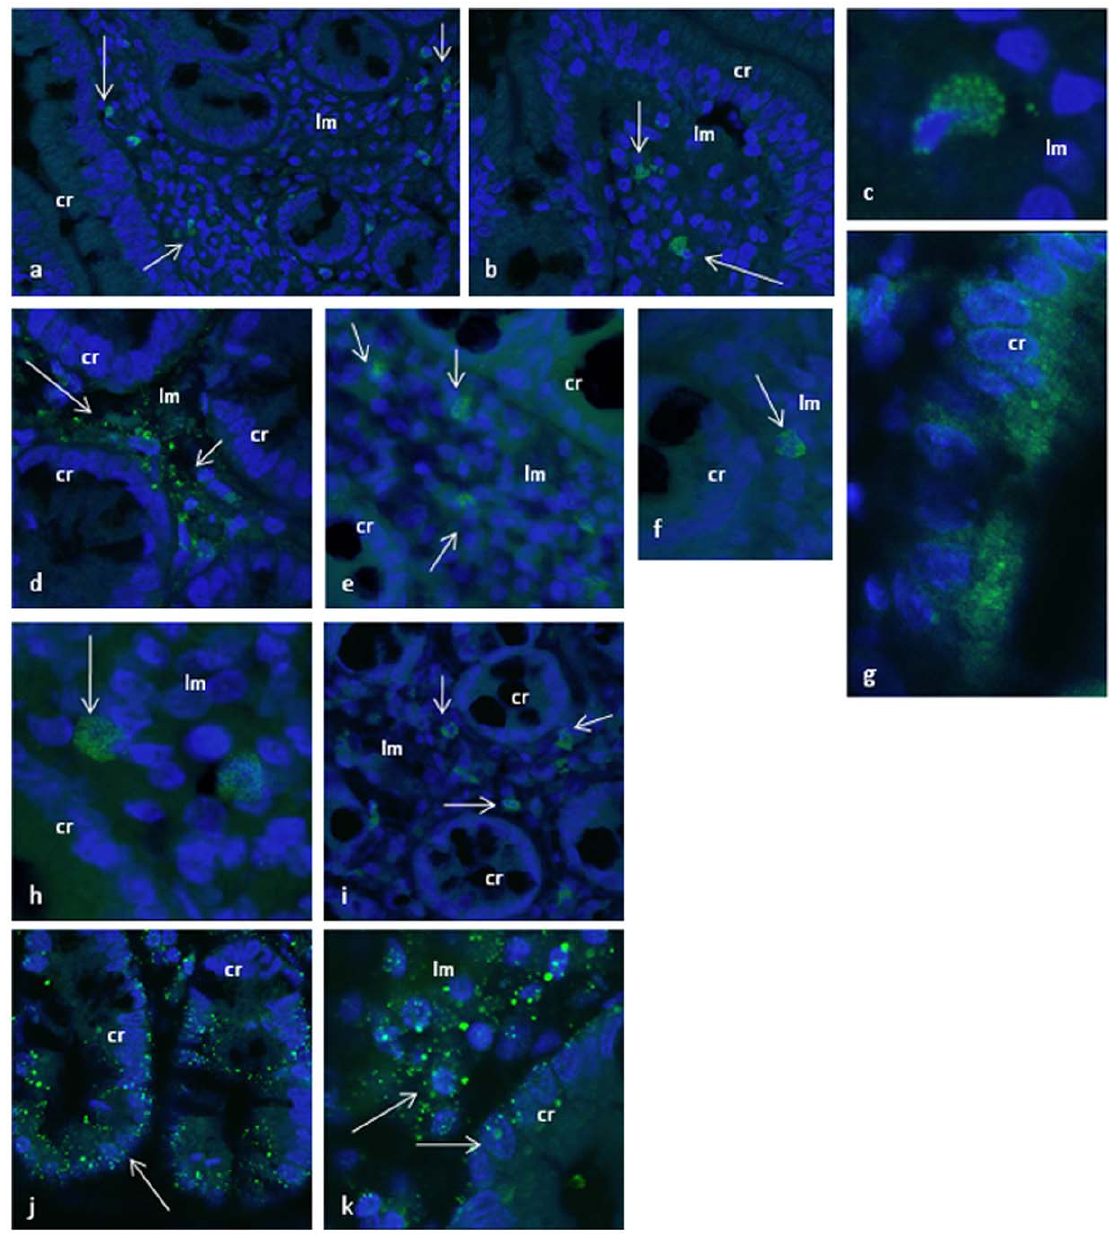
Figure 5. Identification of EP receptors and CD45 in inflamed human small intestine by immunhistochemistry. a – c) CD45 antibody detected positive CD45 cells in the lamina propria (lm) in inflamed tissue. No positive CD45 cells were detected in crypts (cr), d – e) Anti-EP1 antibody detected positive cells in the lamina propria, but no EP1 expression were detected in crypt cells, f – g) Anti-EP2 antibody detected positive cells in both lamina propria (f) and crypts (g), h – i) Anti-EP3 antibody detected positive cells in lamina propria only; no positive cells were detected in crypts, j – k) Anti-EP4 antibody detected positive cells in both lamina propria (j) and crypts (k). Nuclei are stained with Hoechst 33342.